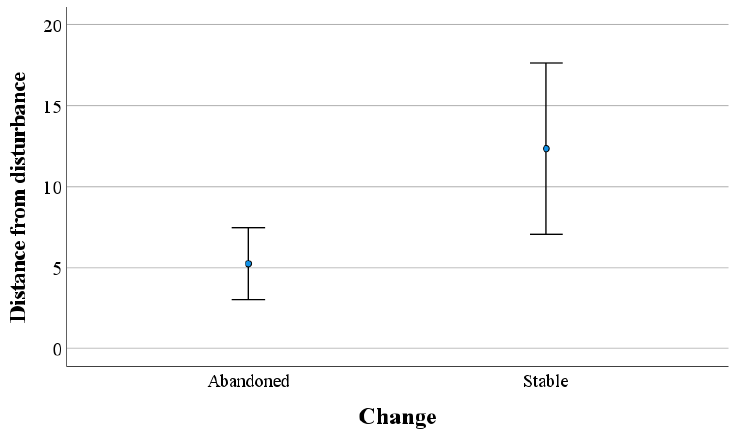
Figure 2. Mean distance (km) ± 2 SE between the central places of eagle owl territories or nest sites that were abandoned ( n = 14) or no change in occupation ( n = 23) and distance to closest disturbance (wind turbine or power line). The change is a comparison of territory occupancy before the construction of the wind farms and power lines started compared with the similar investigation shortly after the construction was finished.